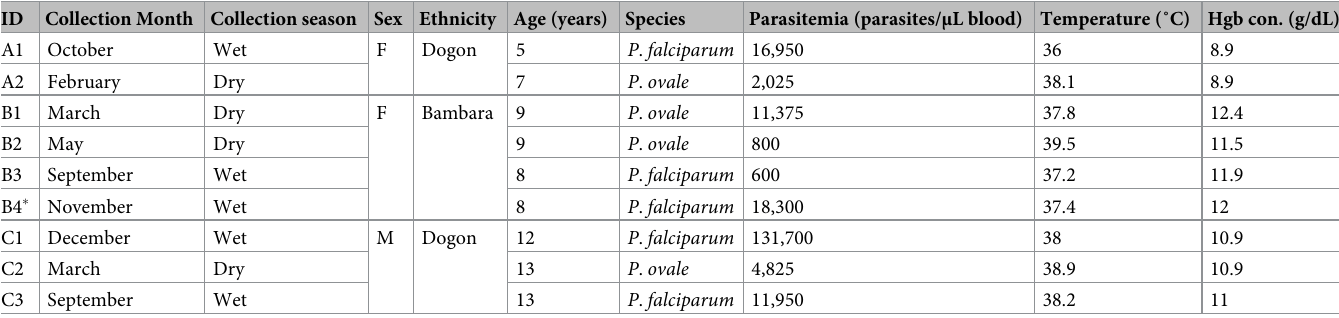
Table 1. Epidemiological and clinical characteristics of study